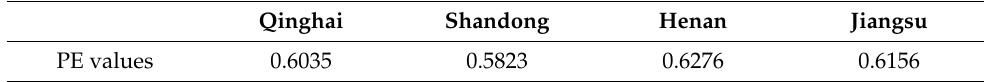
Table 9. Complexity trait test results for